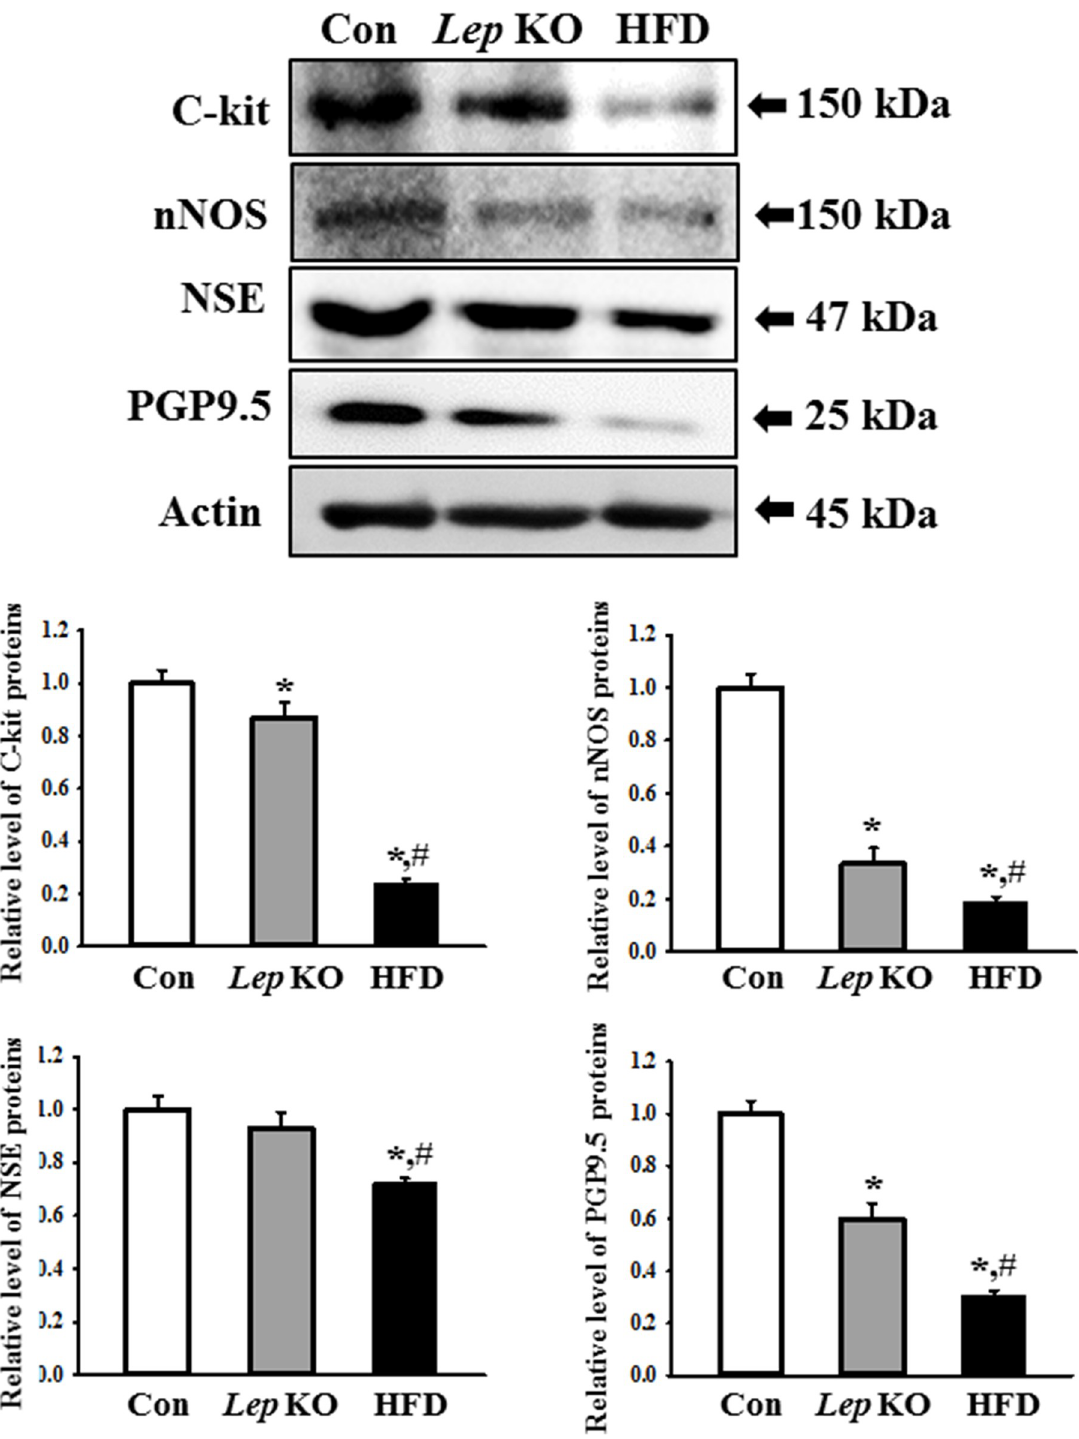
Fig 6. Expression of c-kit, nNOS, NSE, and PGP9.5. The expression levels of four proteins were measured by Western blot analysis using the specific primary antibodies and HRP-labeled anti-rabbit IgG antibody. Three to five mices per group were used to prepare the total tissue homogenate, and Western blot analyses were assayed in duplicate in each sample. The data are reported as the mean ± SD. � indicates p < 0.05 compared to the Con group. Abbreviations: Con, Control group; Lep KO, Leptin knockout mice; HFD, High fat diet; c-kit, Receptor tyrosine kinase; nNOS, Neuronal nitric oxide synthase; NSE, Neuron-specific enolase; PGP9.5, Protein gene product 9.5.